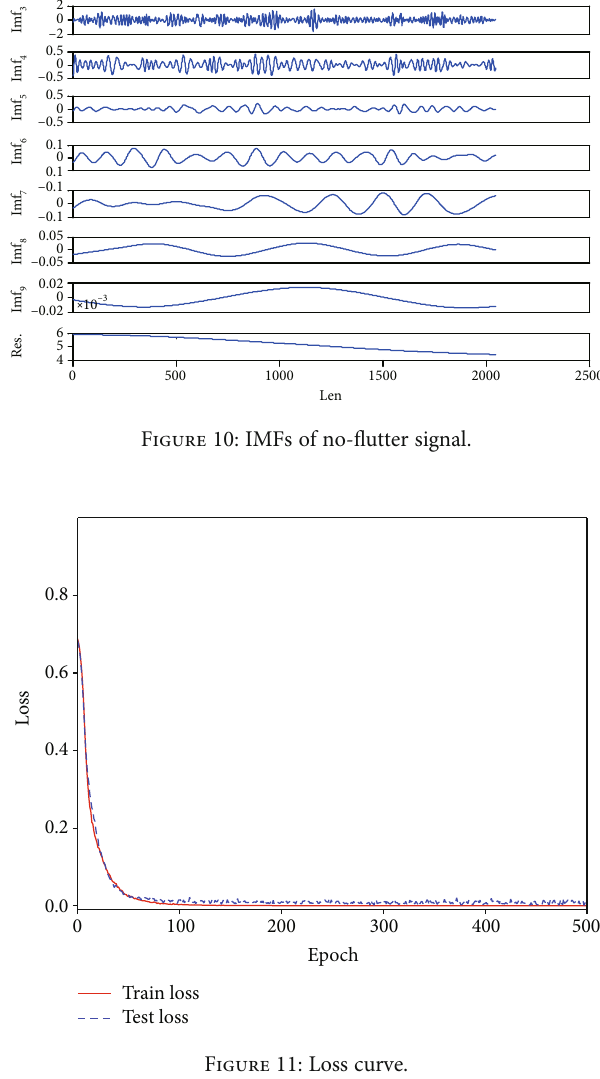
Figure 11: Loss curve.